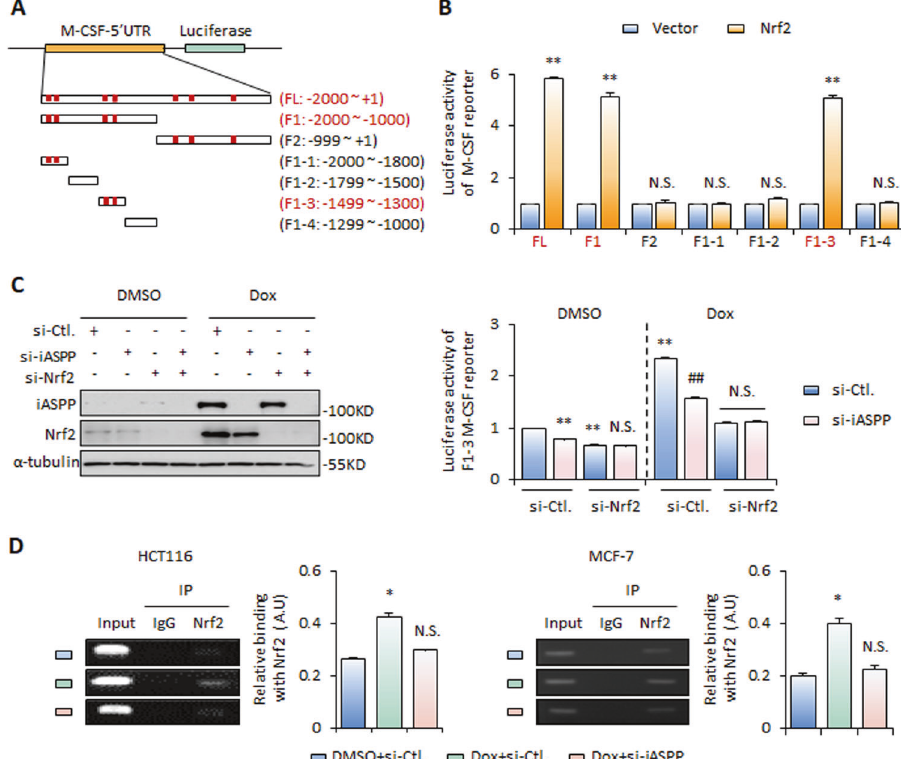
Fig. 3 M-CSF is a novel target of Nrf2. A Schematic diagram of the M-CSF gene promoter region ( − 2000 to + 1 nt) that contains consensus Nrf2 binding motifs, as predicted by JASPAR software (http://jaspar2016.genereg.net). B The activity of M-CSF promoter luciferase reporters was determined by luciferase reporter assay after Nrf2 overexpression (OE). C The activity of M-CSF promoter (F1-3) luciferase reporter activity was determined by luciferase assay after triggering senescence in iASPP and/or Nrf2 KD HCT116 cells ( C ). iASPP and Nrf2 KD de fi ciencies were con fi rmed by western blot. D The interaction between Nrf2 and the M-CSF promoter was analyzed by chromatin IP. Representative images were shown (left). The bands were quanti fi ed by Image J and shown in the bar graph (right). Values are mean ± SD from three